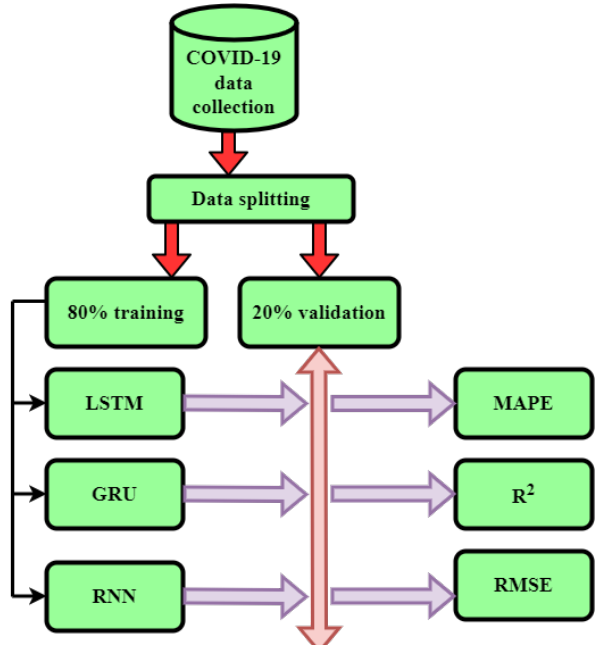
Figure 1. Flowchart of the prediction procedure based on three different DL architectures.